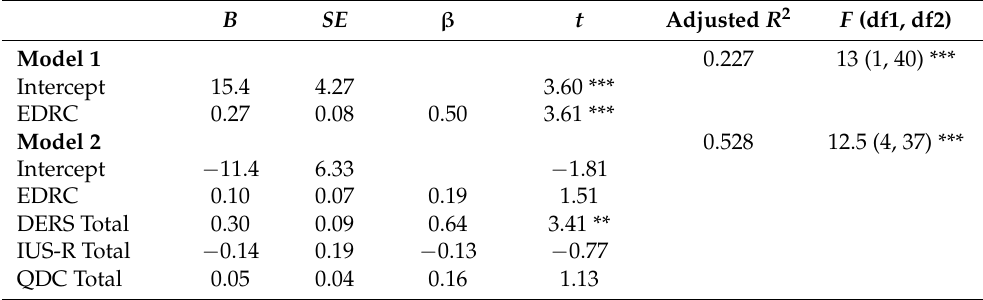
Table 3. Results of the hierarchical multiple linear regression (outcome variable: DASS-21) consider- ing the whole sample ( N =